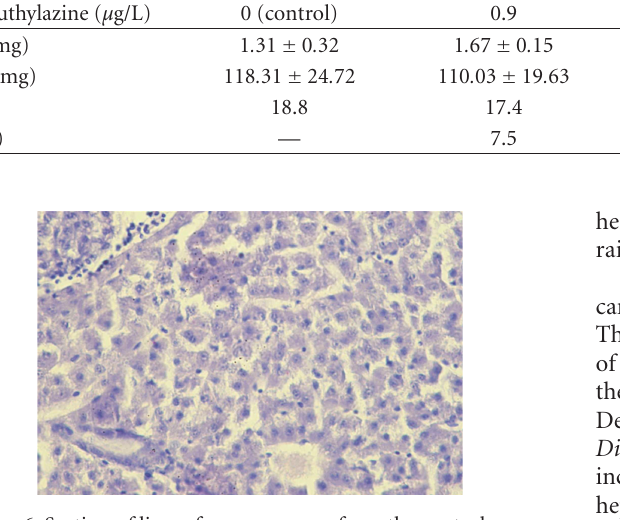
Figure 6: Section of liver of common carp from the control